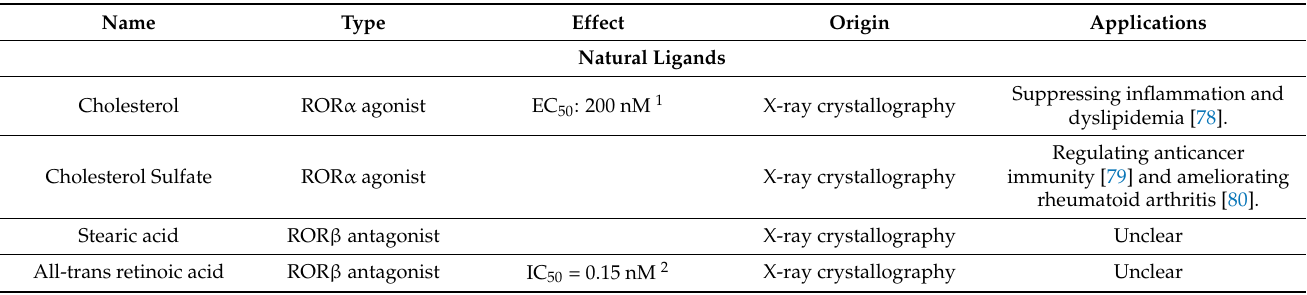
Table 1. Ligands of retinoic acid-related orphan